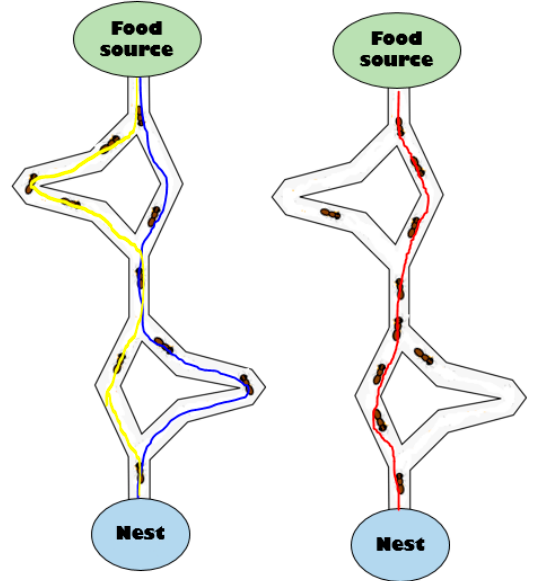
Figure 6. Presentation of the Ant Colony Optimization (ACO)